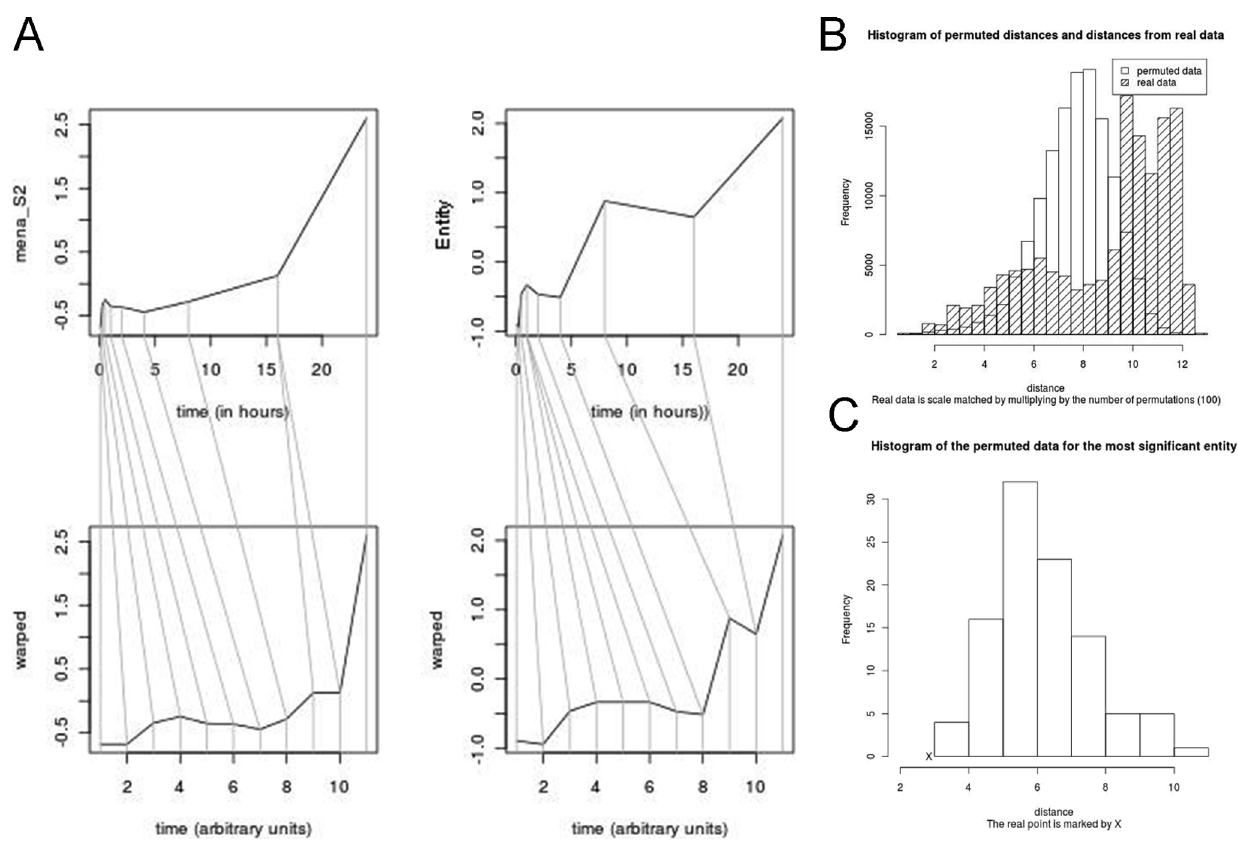
Figure 2. Output plots. A – showing gene and endpoint before and after warping. B – Histogram of real and permuted distances obtained through DTW. C – Histogram of the permuted distances obtained for the most significant gene, with the real distance marked by an X.